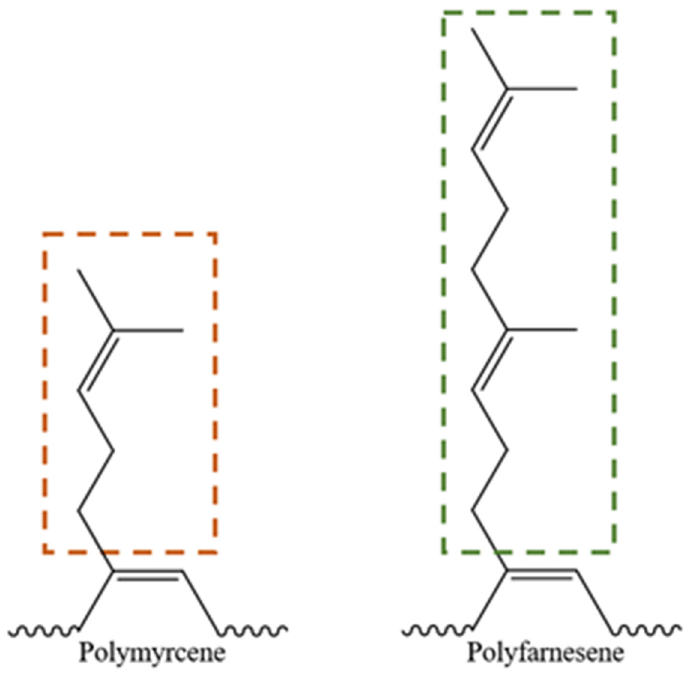
Figure 6. Proposed structures that are produced through the vulcanization of cis -PB [38]. Adapted with permission from Ref. [38]. Copyright (2022) Elsevier Inc.